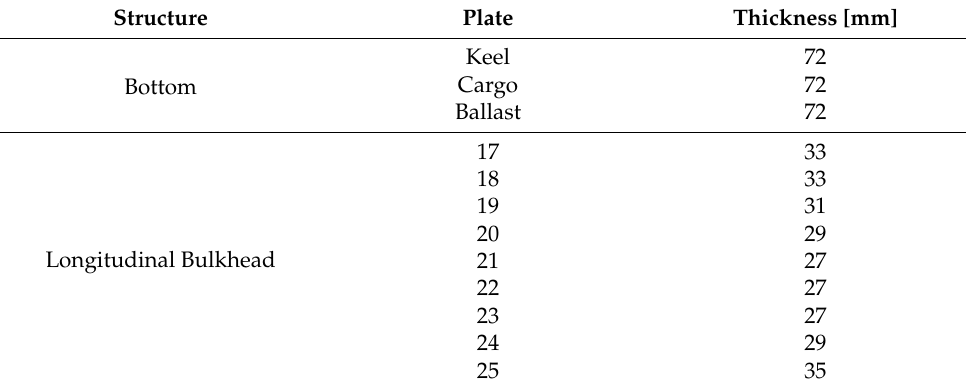
Table 8. Equivalent thickness for the SPS panels.